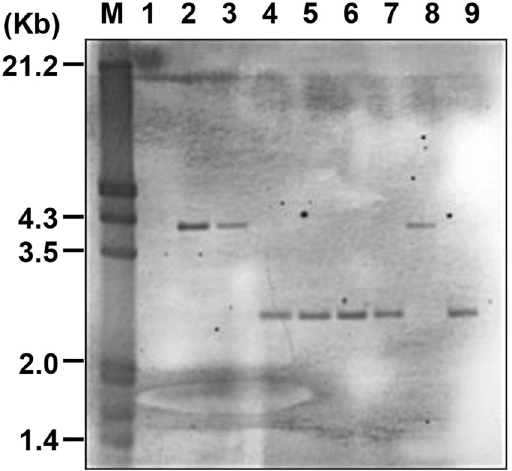
Figure 1. Southern blot analysis of the transgenic chickens. Genomic DNA samples were extracted from whole blood samples from wild-type and transgenic chickens (G1 and G2), digested with EcoRV, electrophoresed, blotted, and hybridized with a probe for the 3D8 scFv gene. M, DIG-labeled DNA marker; lane 1, wild-type chicken; lane 2, P-54; lane 3, P-54 offspring; lane 4, N-82; lane 5, N-95; lane 6, N-165; lane 7, N-183; lane 8, P-196; lane 9,